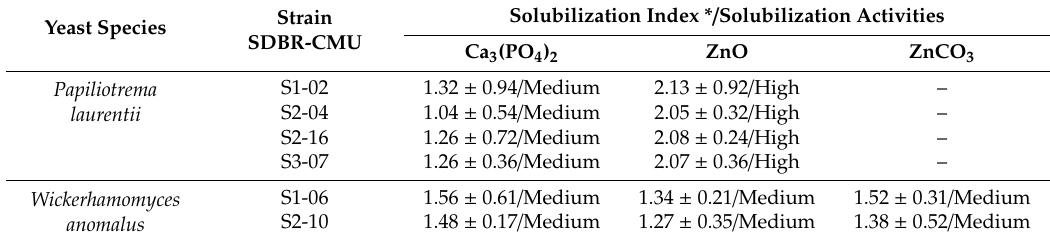
Table 4. Solubilization of insoluble minerals by yeast strains in this study.